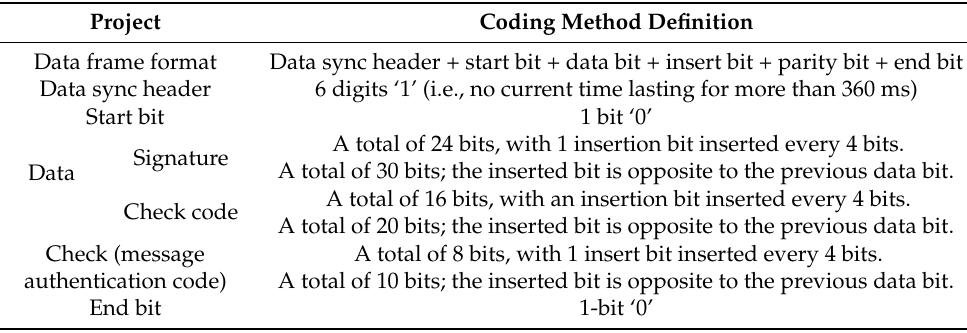
Table 1. Definition of Topology Identification Unit Coding Method.